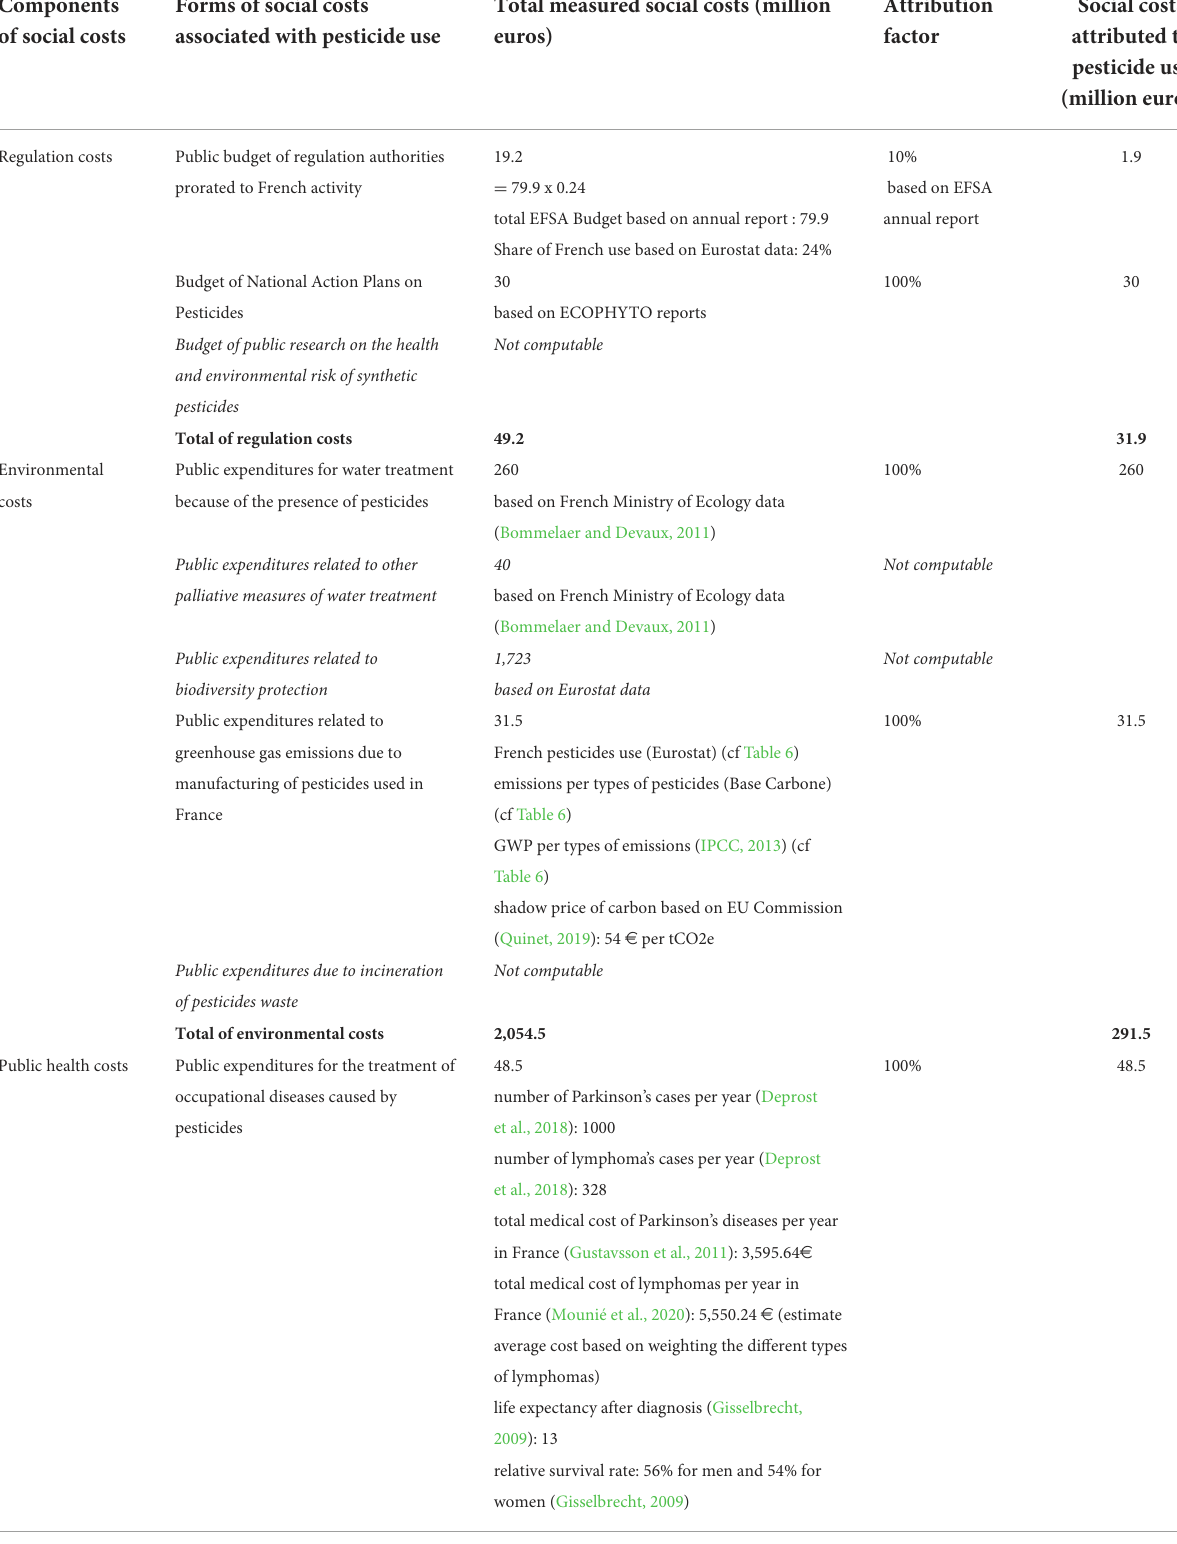
TABLE 5 Summary of the quantified estimates obtained for the social costs associated with synthetic pesticide use in France.